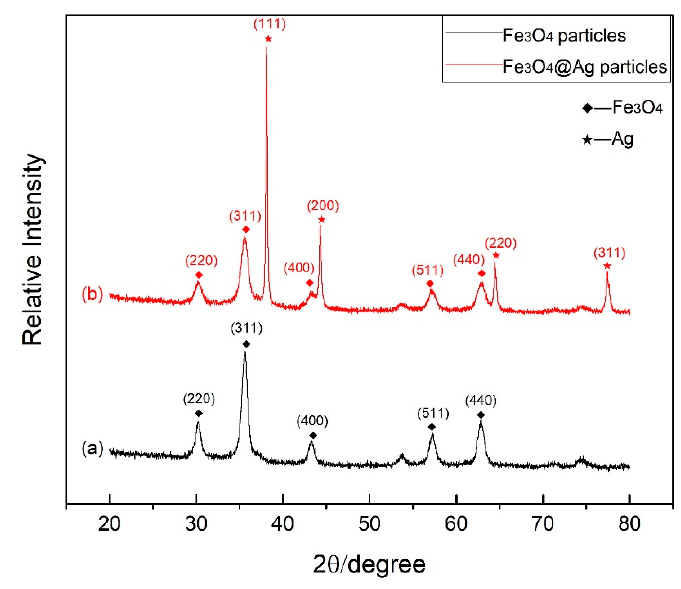
Figure 2. XRD patterns of ( a ) Fe 3 O 4 particles and ( b ) Fe 3 O 4 @Ag particles.